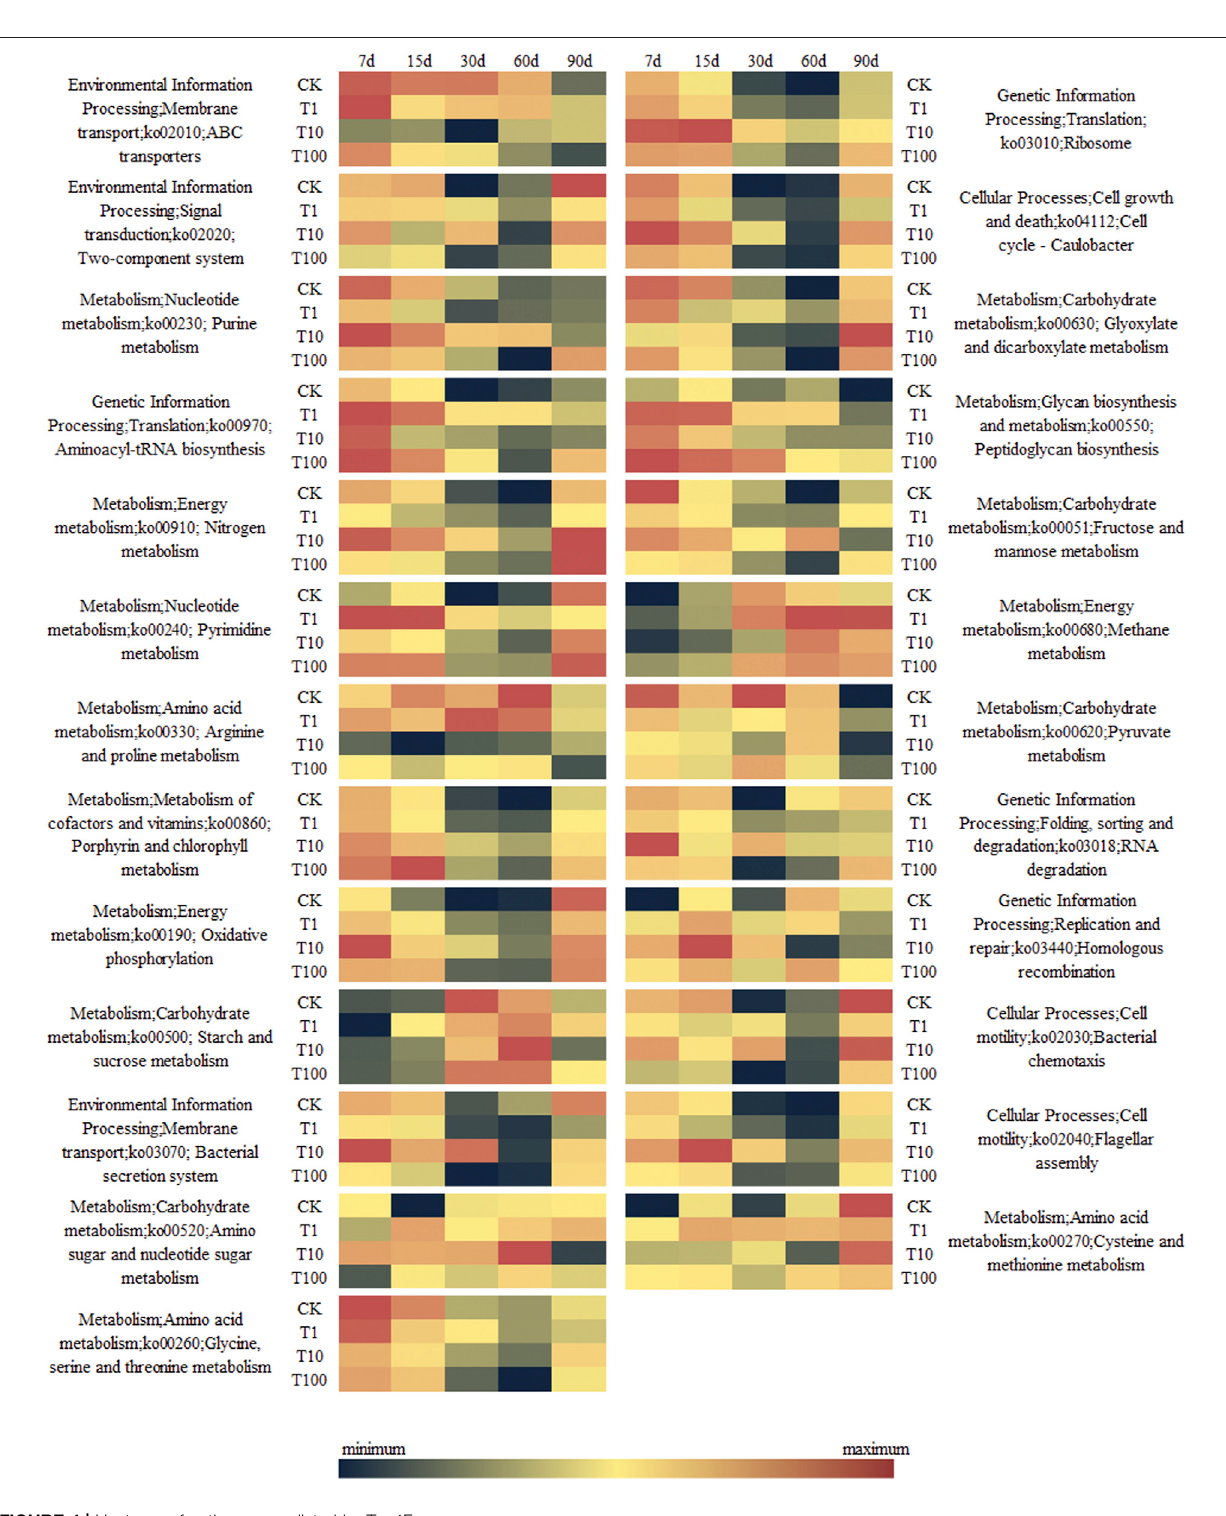
Frontiers in Environmental Science |